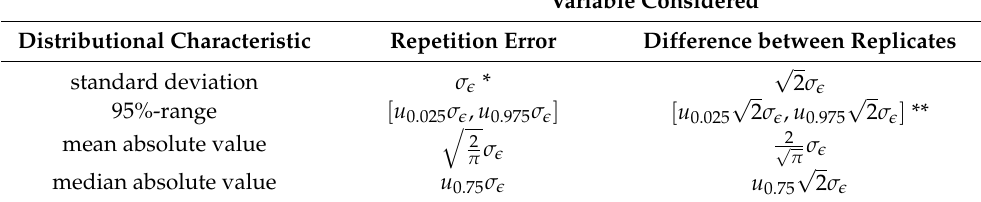
Table 1. Distributional characteristics of the repetition error and the difference between replicates expressed as a function of the standard deviation σ (cid:101) of the repetition error. u α denotes the α -quantile of a standard normal distribution. For concrete computations, the following approximate values √ can be used: 2 = 1.4142, u 0.025 = − 1.96, u 0.975 = 1.96, u 0.025 (cid:113) repetition error is reported, often the term Standard Error of Measurement (SEM) is used. **: The half width of this interval is often reported as the repeatability coefficient when using two replicates over time